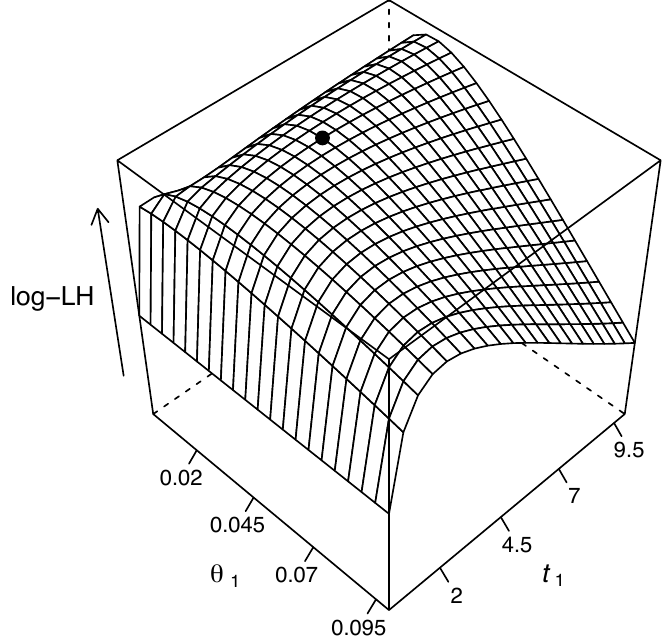
Figure 3. Likelihood surface with respect to parameters θ 1 and t 1 estimated from the joint site frequency spectrum in Table 1. The point on the likelihood surface corresponds to ML estimates: ˆ θ 1 = 0.03 and ˆ t = 1